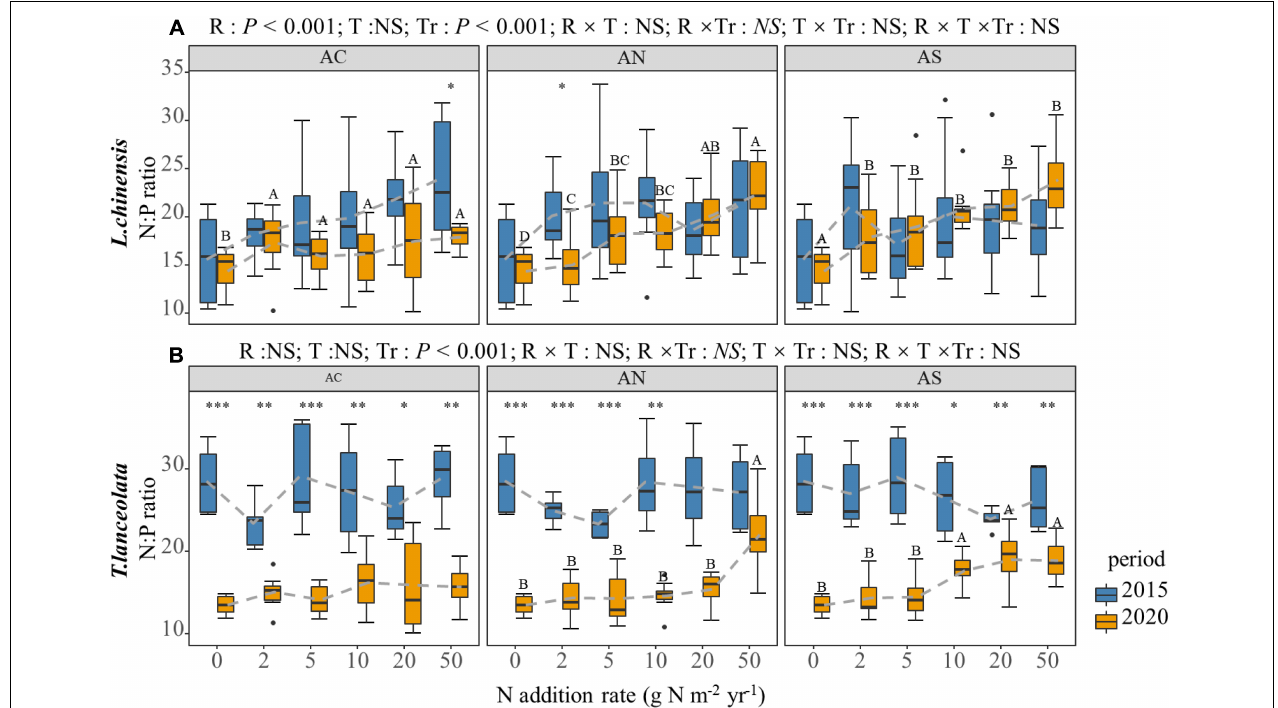
FIGURE 3 | Effects of short- and long-term nitrogen deposition on N:P of two species: (A) Leymus chinensis ; (B) Thermopsis lanceolata . The three-way ANOVA was used to test the effects of Pr, T and R on N:P. The effects of the nitrogen compound type alone and with nitrogen addition rate and year on N:P are not significant (NS, P > 0.05), thus one-way ANOVA (Tukey’s HSD) and t -tests are used to test the effects of nitrogen addition rate and year on N:P. Different lower-case and upper-case letters indicate significant differences ( P < 0.05) in LN among nitrogen addition rate in the 2015 and 2020 plots, respectively. The asterisk above the picture indicates the significant difference between the two years under each nitrogen addition rate. Note: ∗ P < 0.05; ∗∗ P < 0.01; ∗∗∗ P < 0.001. CK: non-fertilizer control = 0, N1 = 2, N2 = 5, N3 = 10, N4 = 20, and N5 = 50 kg N ha − 1 yr − 1 ; AC (NH 4 HCO 3 ), AN (NH 4 NO 3 ), AS [(NH 4 ) 2 SO 4 ]. The gray dashed line is the connection of the mean